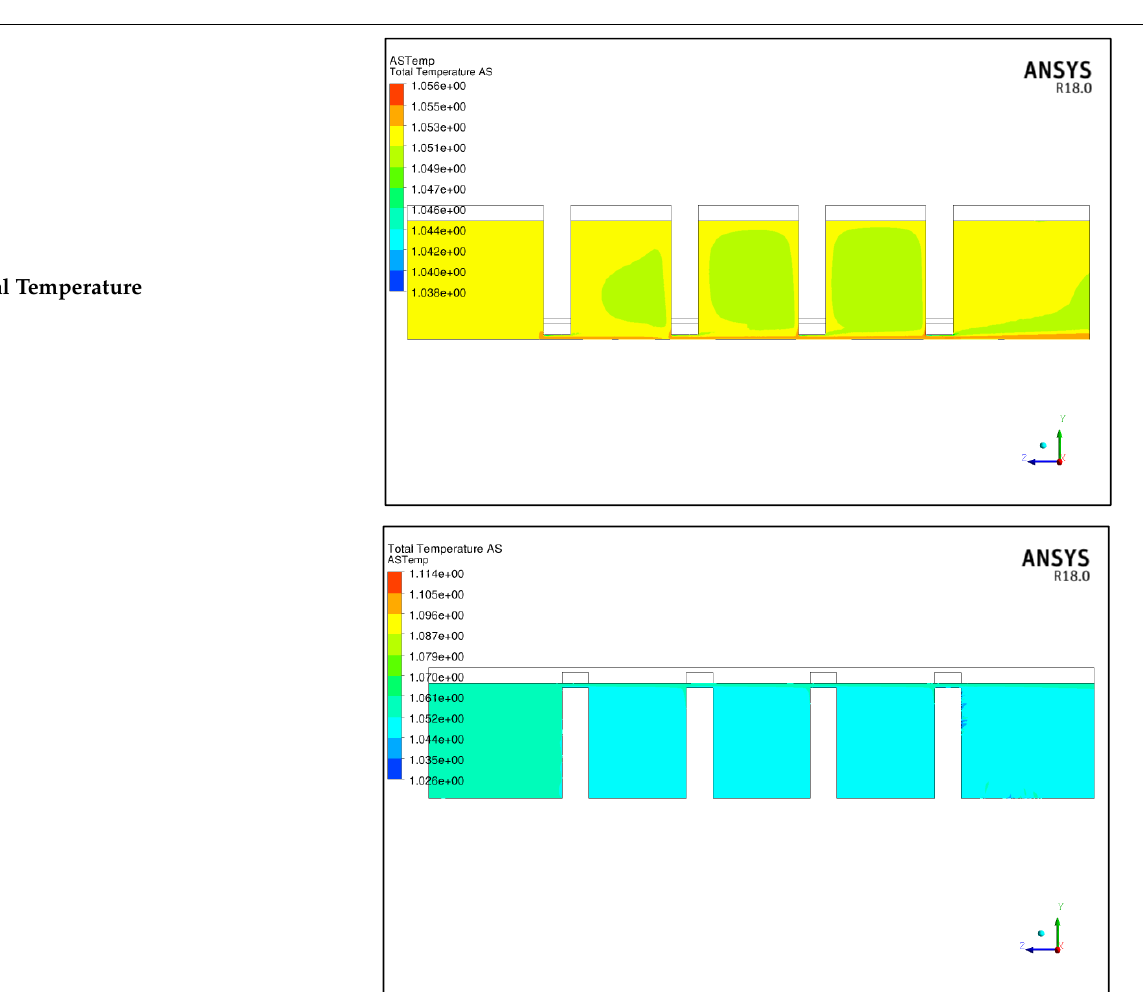
Table A8. Static pressure